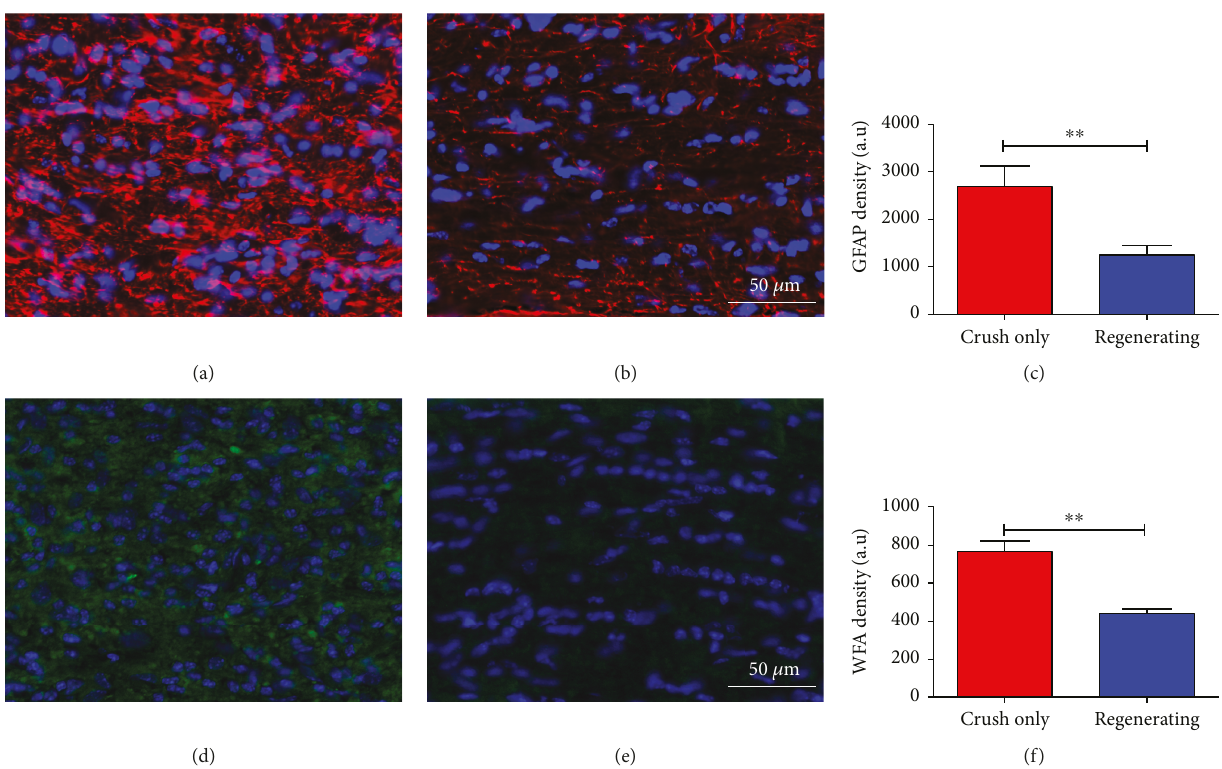
Figure 4: Reactive astrogliosis within the optic nerve. (a – c) GFAP (red) and nuclear staining (blue) two weeks after injury. (a) Optic nerve from the Crush-only group showing an intense GFAP staining; (b and c) optic nerve and quantitative analysis exhibiting reduced levels of GFAP in the Regenerating group. (d – f) WFA (green) and nuclear staining (blue) two weeks after injury. (d) Optic nerve from the Crush-only group. (e and f) Optic nerve image and quantitative analysis presenting reduced levels of WFA density in the Regenerating group. N = 5 per group. Scale bars: (a, b, d, e) 50 μ m. Error bars in (c) and (f) show SEM. ∗∗ P < 0 01